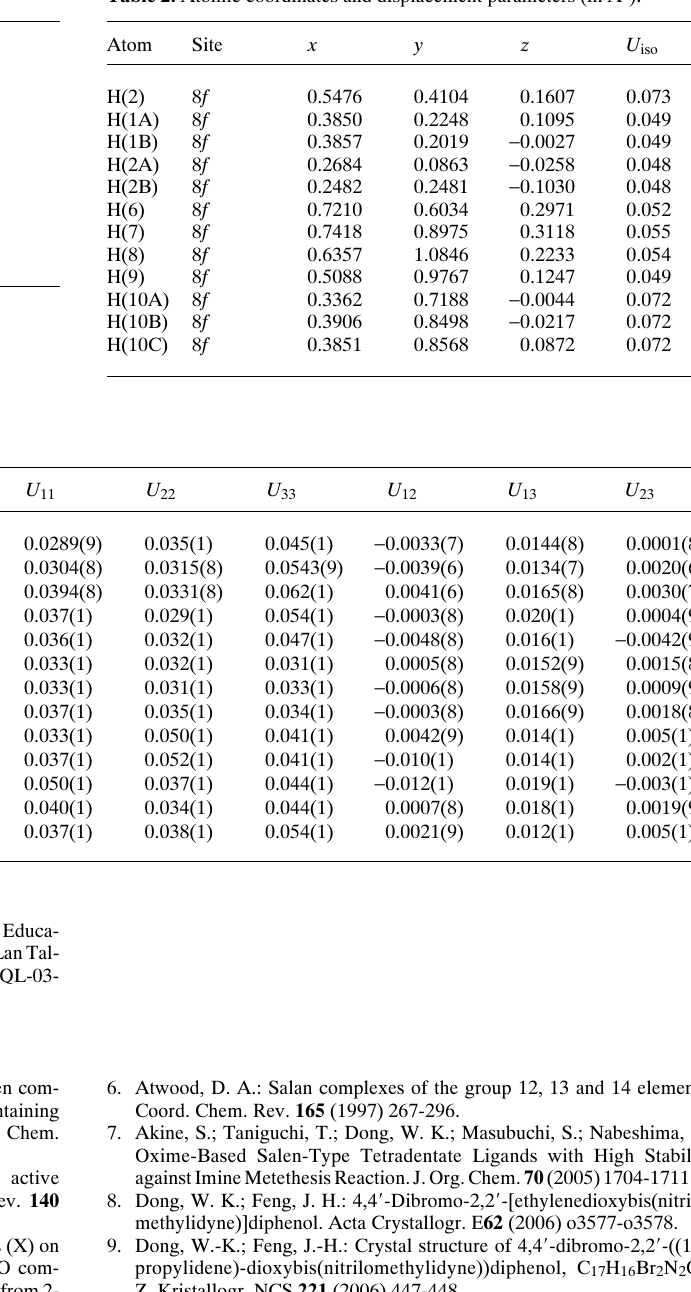
Table 2. Atomic coordinates and displacement parameters (in Å 2 ) . Table 1. Datacollection and